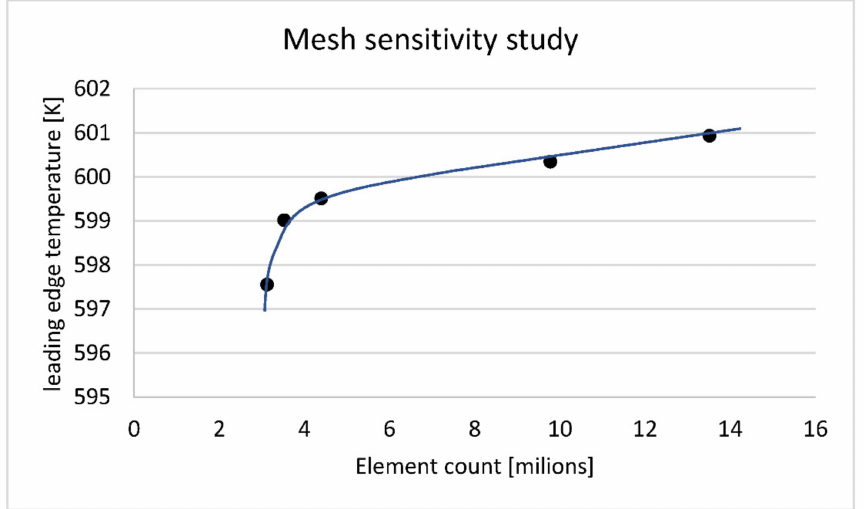
Figure 14. Mesh refinement impact to the midspan leading edge